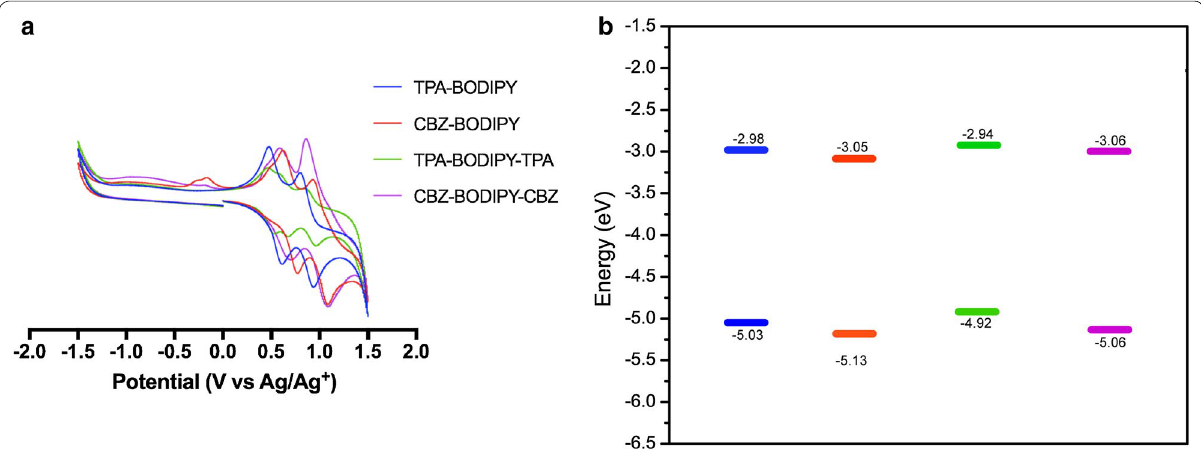
Fig. 3 a Cyclic volttammograms of BODIPY dyads and triads in 0.1 M TBAPF 6 /CH 2 Cl 2 measured against Ag/Ag as the internal standard and b energy alignments of BODIPY dyads and triads